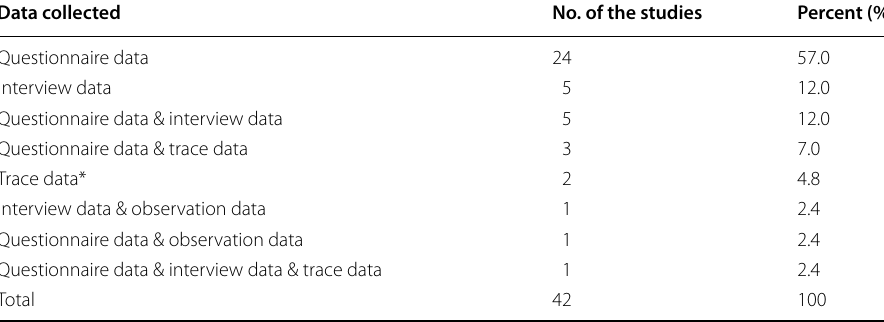
*Trace data refers to records of activity undertaken through learning management systems